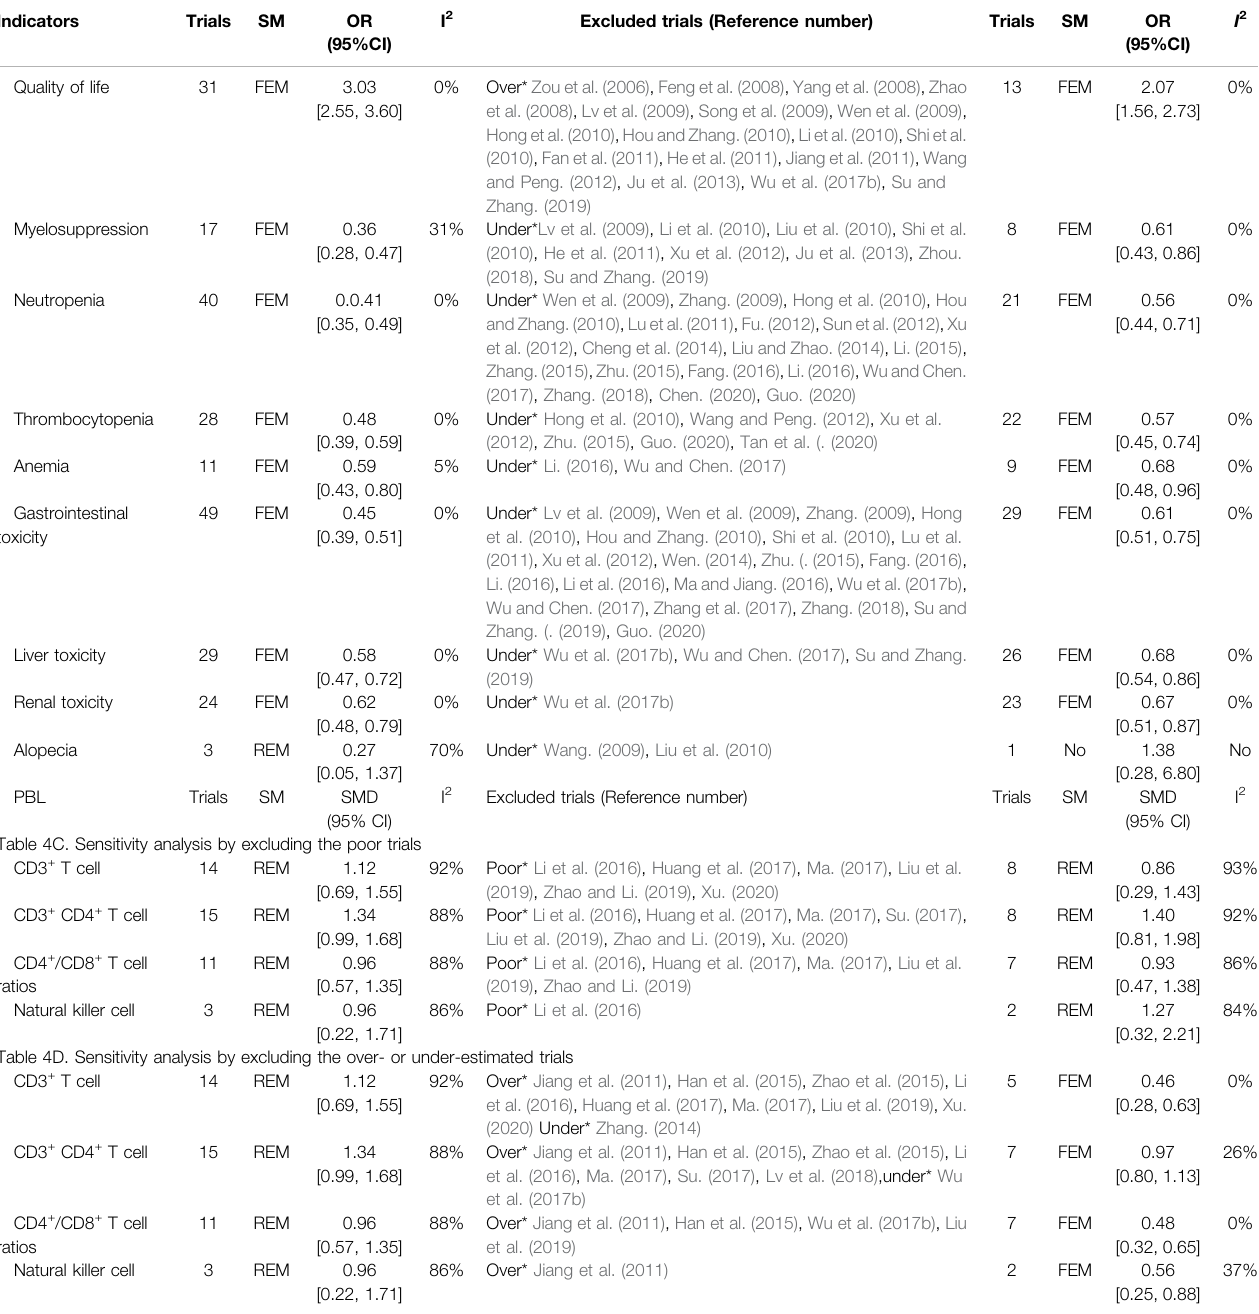
Table 4D. Sensitivity analysis by excluding the over- or under-estimated trials CD3 + T